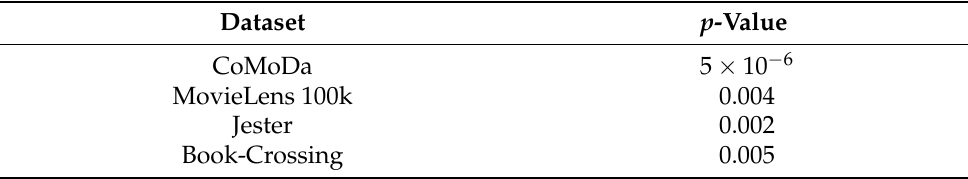
Table 2. Statistical testing results for significance value of α = 0.05.